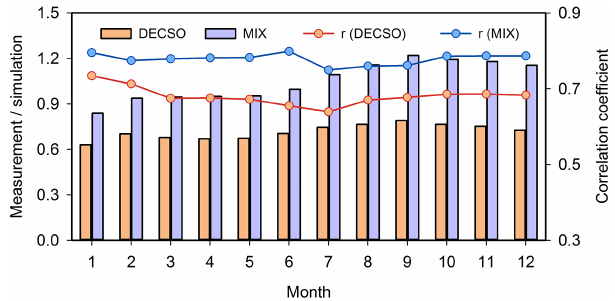
Figure 9. Monthly mean ratio of simulated surface NO 2 concentra- tions driven by the DECSO inventory, 2015 (red bar), and the MIX Asian inventory, 2010 (blue bar), with the corrected in situ mea- surements (left axis). The correlation coefficient of the simulated NO 2 concentrations versus the corrected in situ measurements is displayed on the right